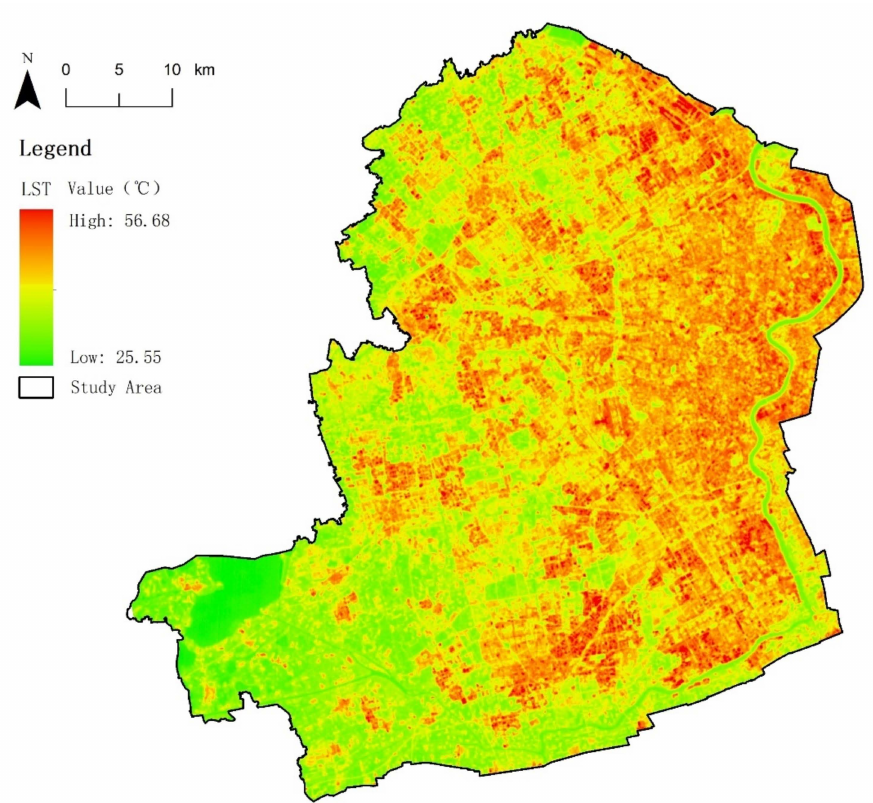
Figure 3. Distribution map of the study